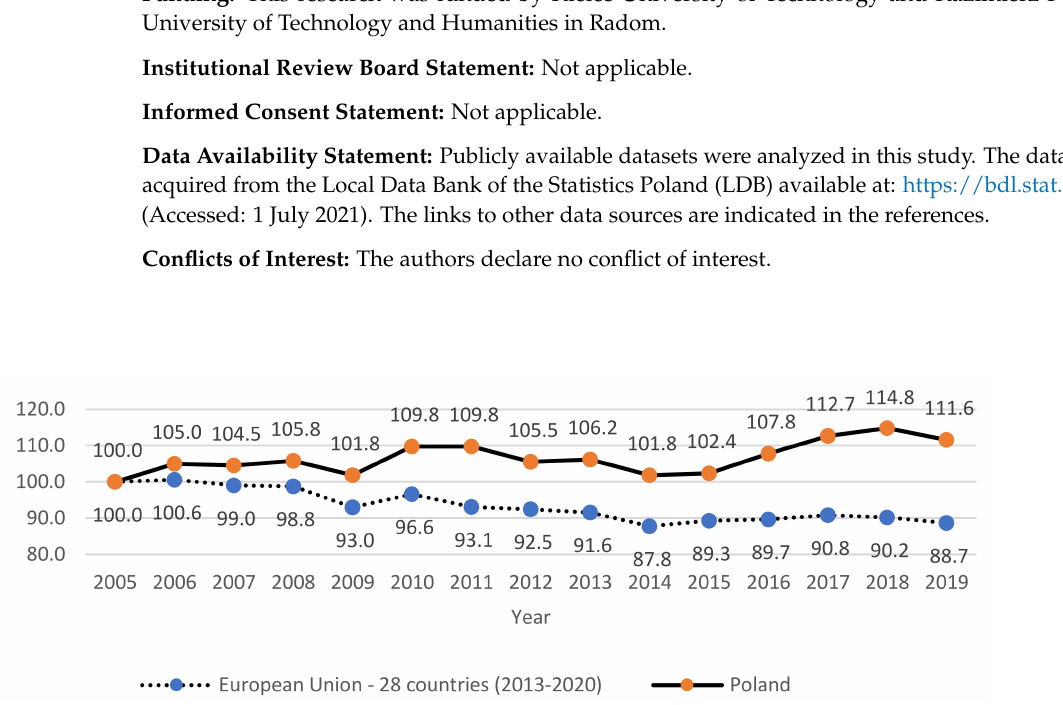
Figure A1. Primary energy consumption (% of the base year 2005 amount) in Poland vs. EU28 in 2005–2019. Source: own elaboration based on